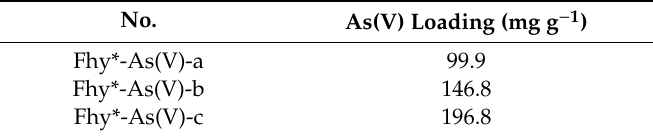
Table 1. The loaded As(V) amounts on Fhy at pH